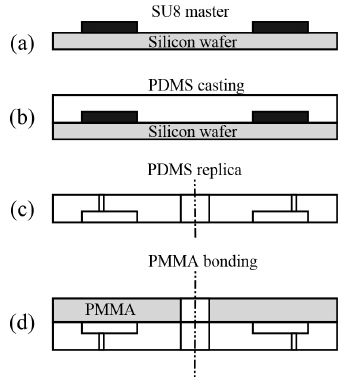
Figure 3. The fabrication process for the microfluidic disc. ( a ) SU-8 photolithography and development; ( b ) Pouring of PDMS and curing; ( c ) Demolding of PDMS replica and punching holes; ( d ) Bonding PDMS to PMMA disc